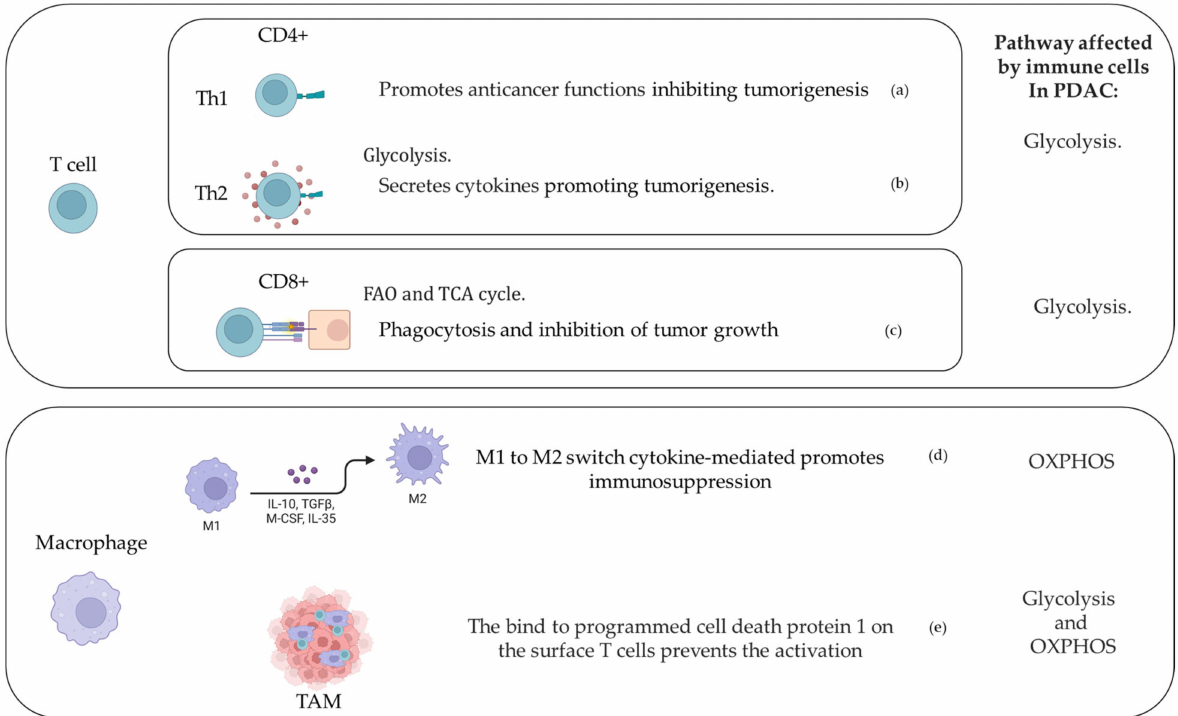
Figure 2. T-cell and macrophage activity in the PDAC-conditioned environment. ( a ) [154,169]; ( b ) [171]; ( c ) [148,172]; ( d ) [164]; and ( e )